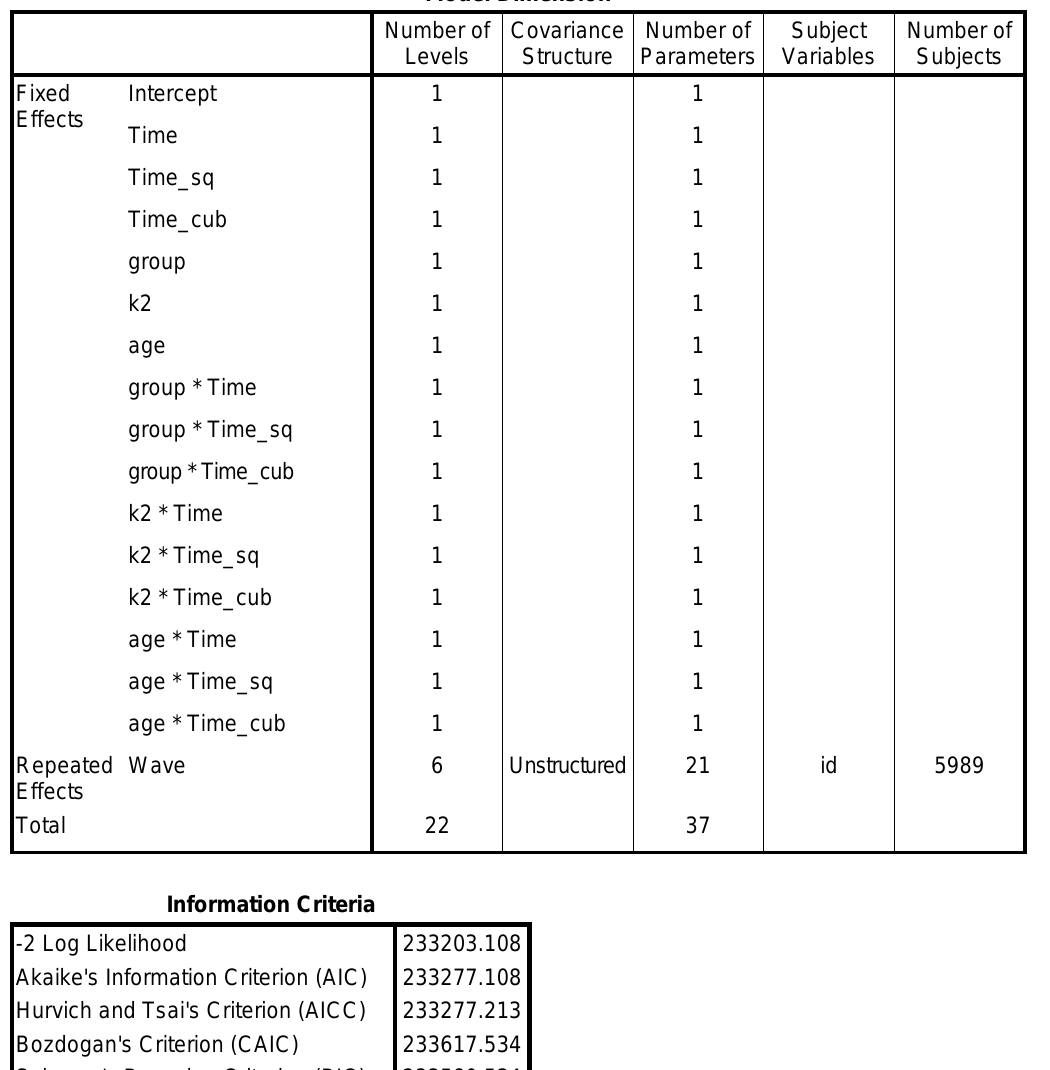
Model 6: Testing Error Structure Covariance Structure